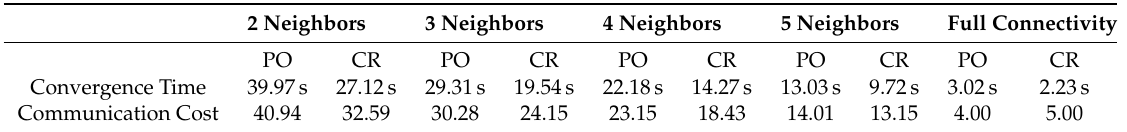
Table 5. Comparison of position-only co-regulation compared against full co-regulation of both communication and position with varying connectivity. CR, full co-regulation; PO, position-only